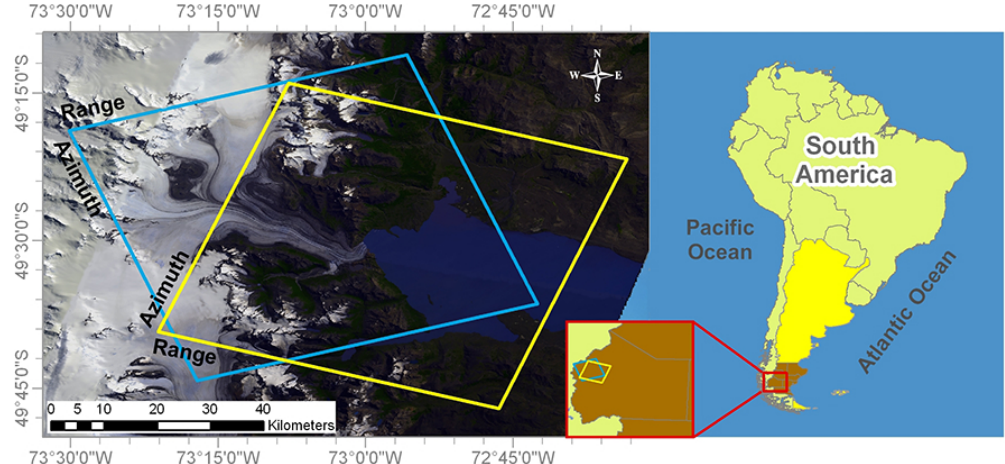
Fig. 1. Viedma Glacier (Santa Cruz province, Argentina). Aster images acquired on February 2005 and 2010 show the area of interest. Area illuminated by COSMO-SkyMed acquisitions is highlighted by square boxes. Yellow box indicates the area covered by the descending orbit whereas blue box indicates that covered by the ascending one. Aster images source is http://terralook.cr.usgs.gov/.